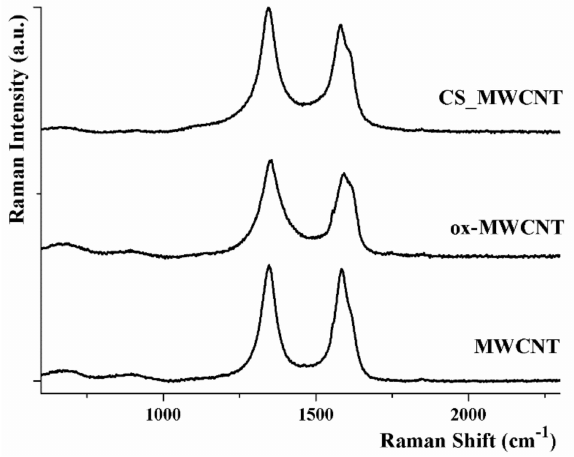
Figure 3. Raman spectra of MWCNT, ox-MWCNT, and CS_MWCNT. For all samples, D and G bands are located at 1347 and 1582 cm − 1 ,